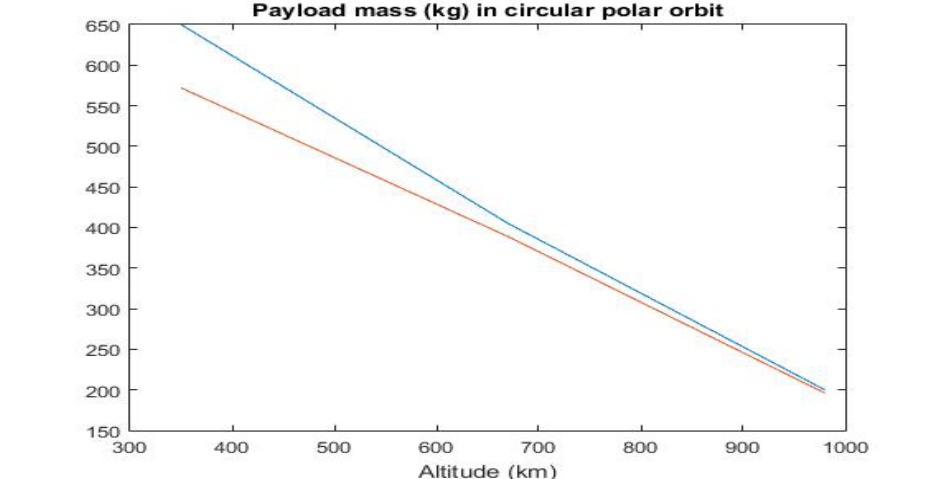
Figure 12. Payload mass of polar circular orbits of different altitudes, analytical (blue line) vs numeric results (orange